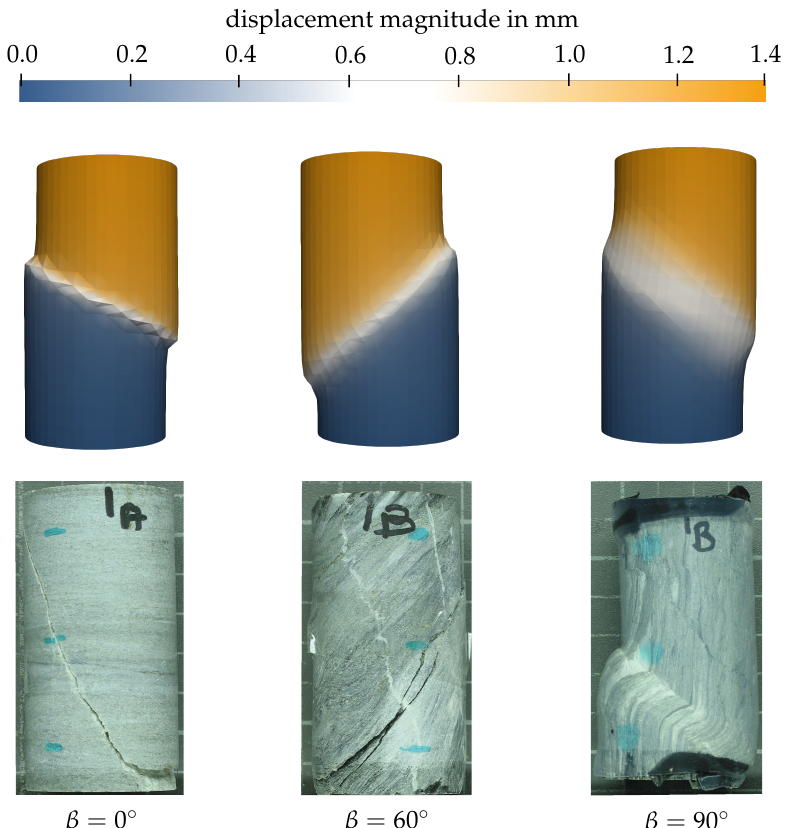
Figure 7. Computedfailure modes for σ 0 = 12.5 MPa for the three inclination angles of the foliation planes β = 0 ◦ , 60 ◦ and 90 ◦ compared to the experimentally determined failure modes according to Blümel [51] (Images of experiments reprinted with permission from Ref. [51], 2014,